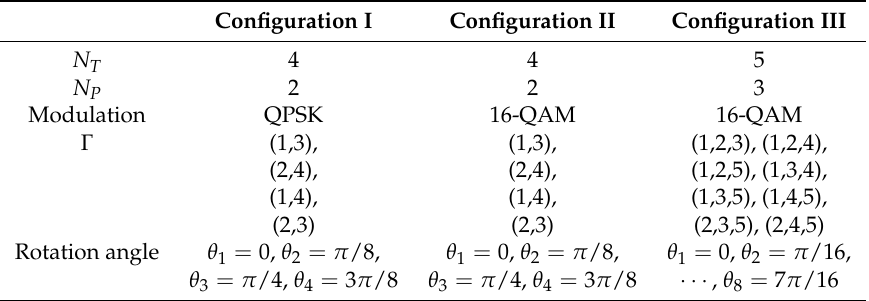
Table 1. MA-SM system